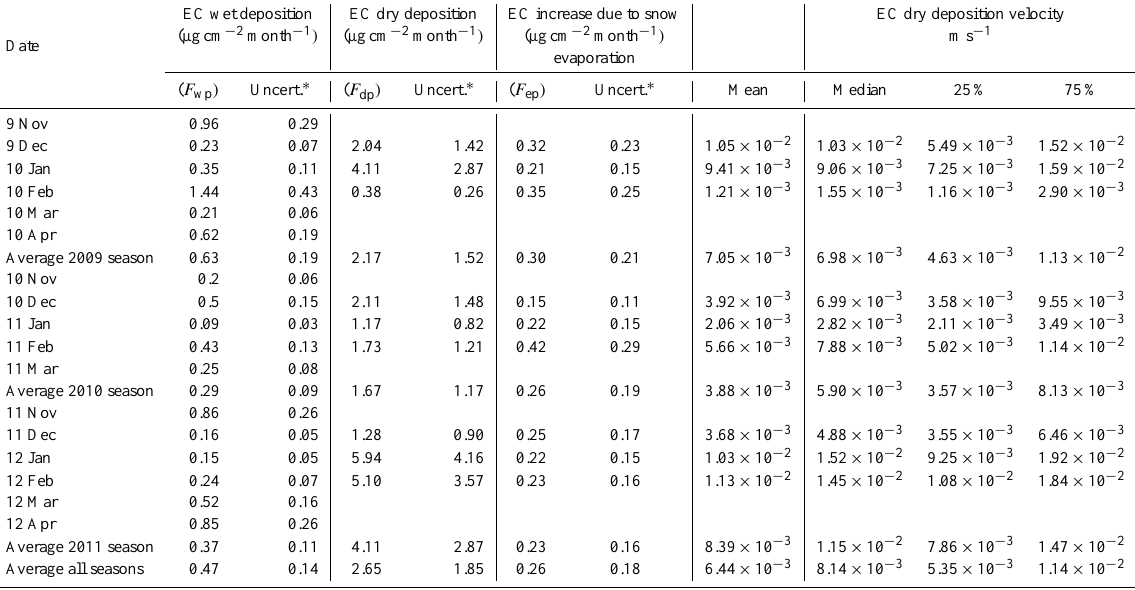
Table 2. Deposition fluxes and dry deposition velocity of EC on snow surface during snow seasons 2009–2011 (uncertainty). The blank cells correspond to periods with no possibility of the estimation of snow evaporation because of melting (and therefore dry deposition of EC).